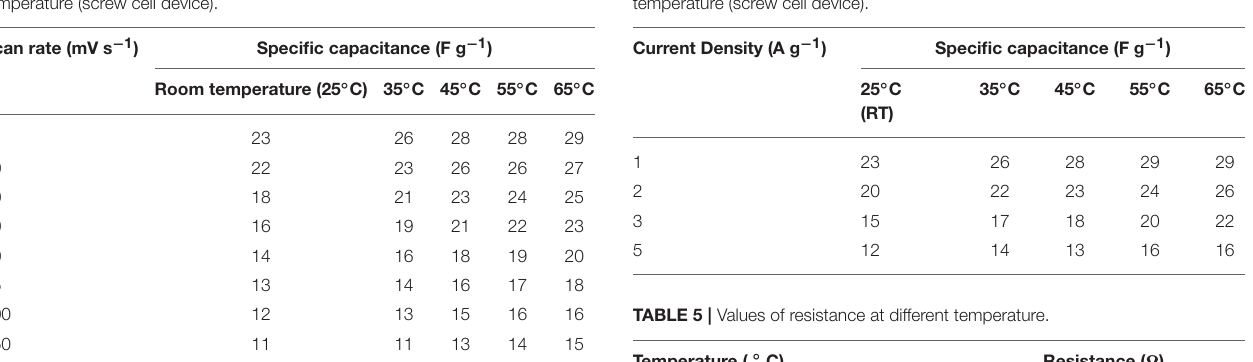
TABLE 4 | Values of specific capacitance at different current densities at different temperature (screw cell device).